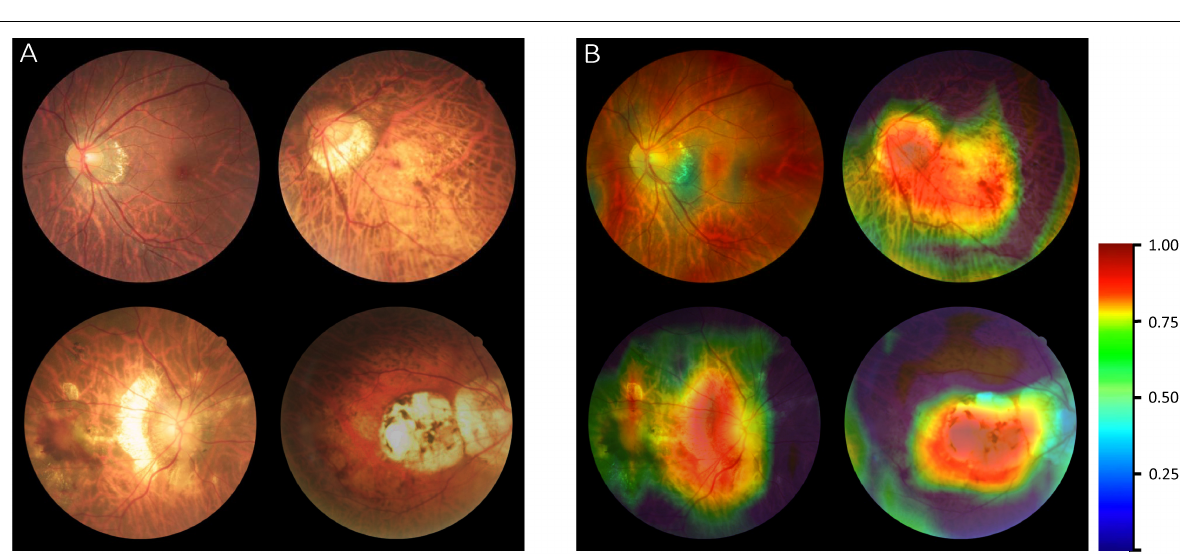
FIGURE 4 | Visualization of algorithm II for classifying the category of myopic maculopathy (MM). (A) The original images of different MM (Category 1–Category 4). (B) Heatmap generated from deep features overlaid on the original images. The typical MM lesions were observed in the hot